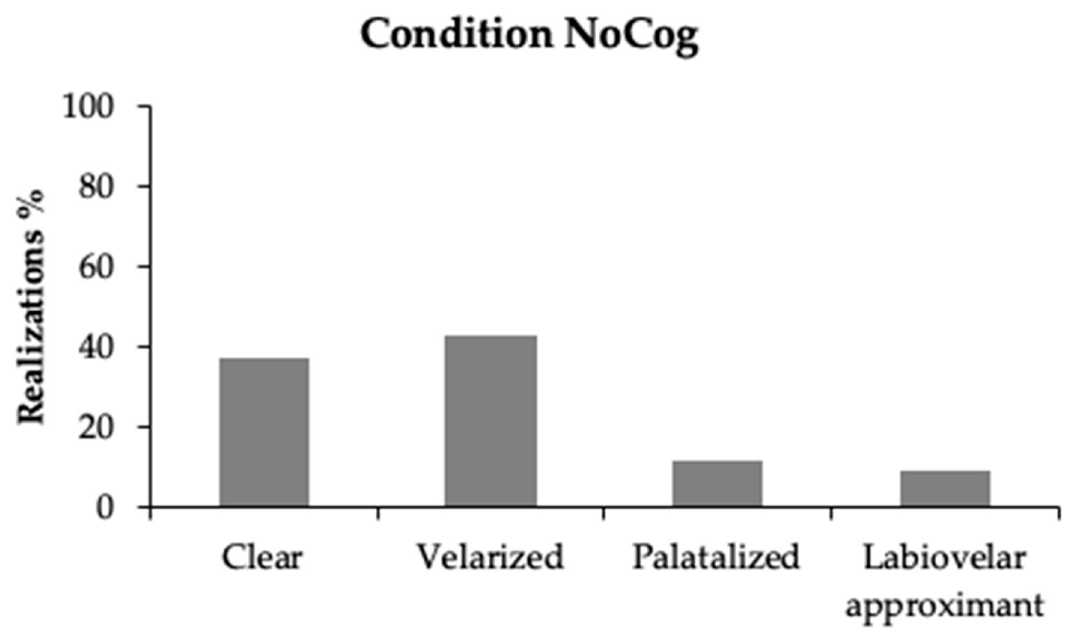
Figure 5. The production of the L3 lateral in condition NoCog.